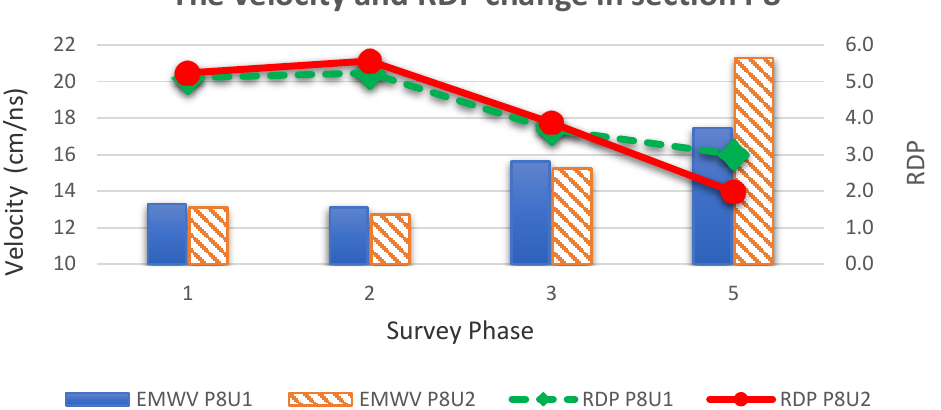
Figure 12. The change of EMWV and RDP values during the lifecycle of the railway track in section P8.